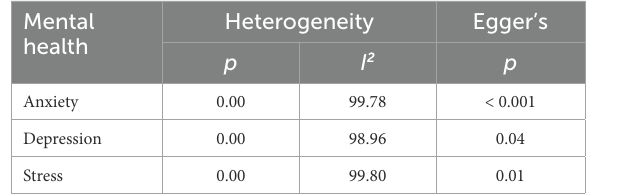
TABLE 4 Heterogeneity and publication bias test.